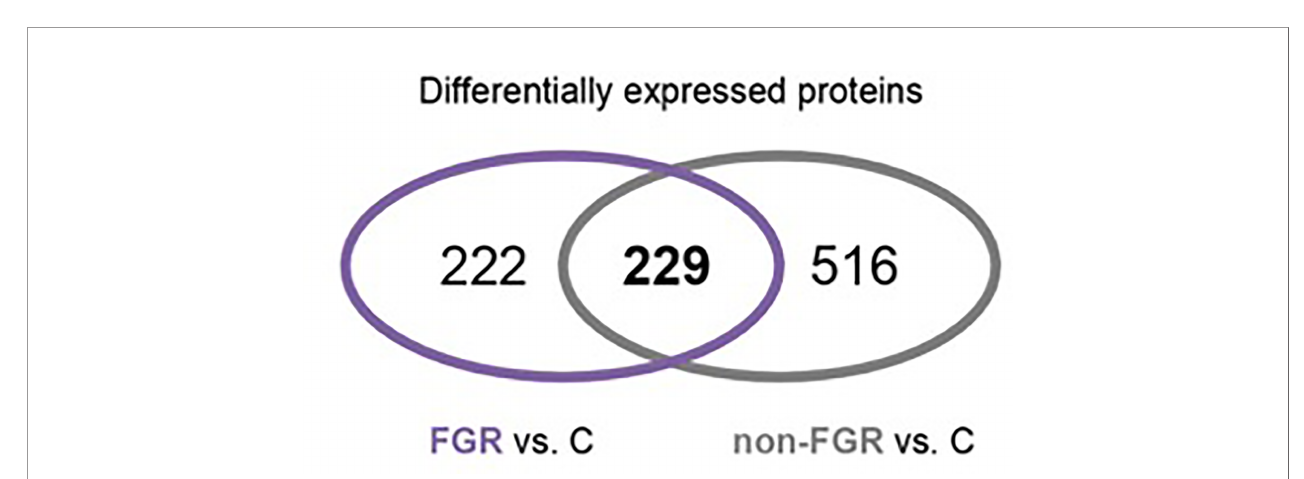
FIGURE 3 | Venn diagram of common Differentially expressed proteins in FGR vs. Control and non-FGR vs. Control